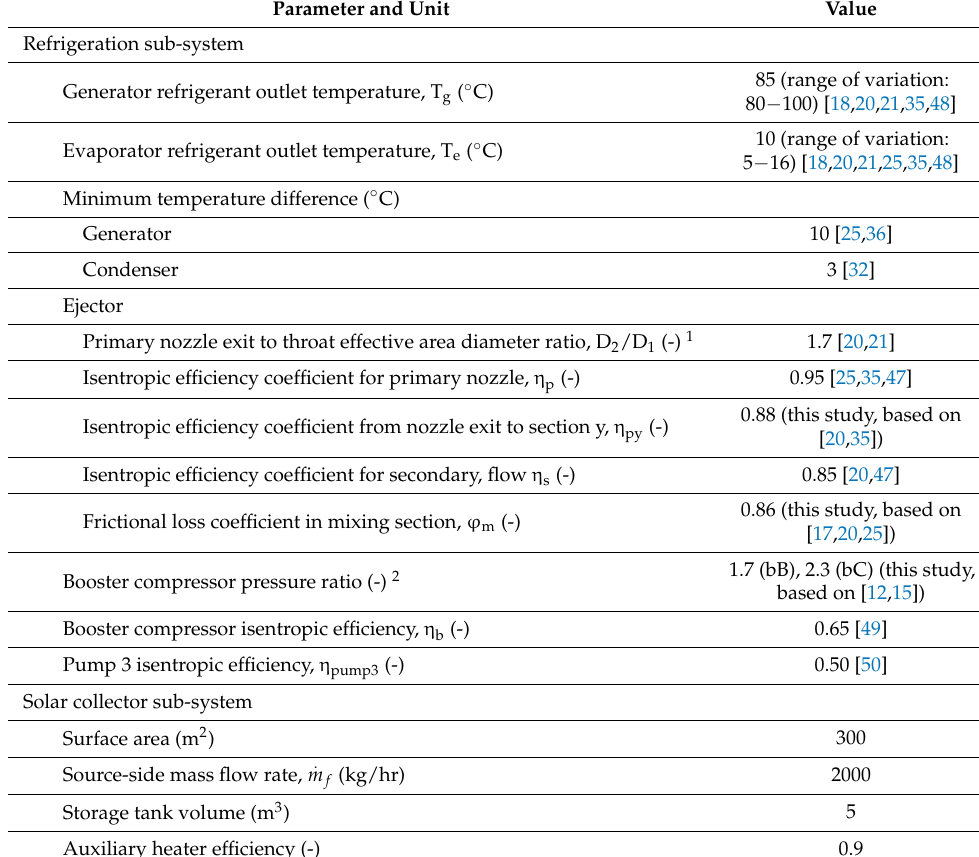
Table 2. Input modeling parameters for the refrigeration sub-system and ejector